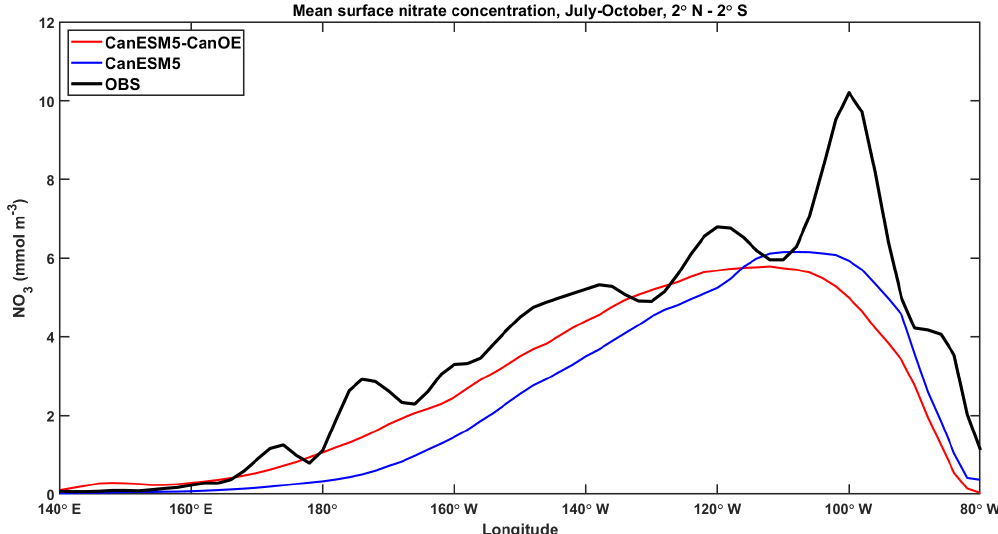
Figure 15. Surface nitrate (NO 3 ) concentrations along the Pacific Equator (mean from 2 ◦ S–2 ◦ N) during the upwelling season (June– October) for CanESM5-CanOE (red), CanESM5 (blue), and WOA2018 observations (black).